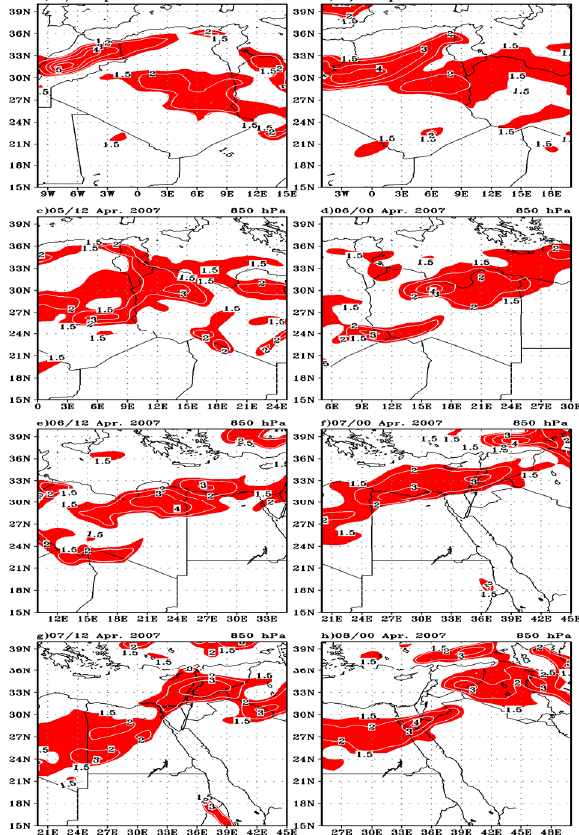
Figure 12. The meridional temperature gradient at 850 hPa that ≥ 1.5 °C/km at 12Z and 00Z for 4–8 April 2007.